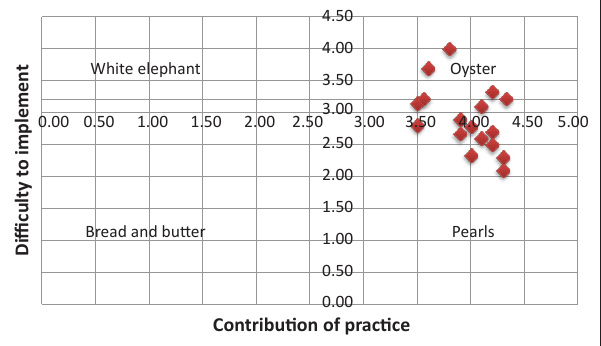
FIGURE 3: Contribution versus difficulty in implementing practices to overcome cost-related